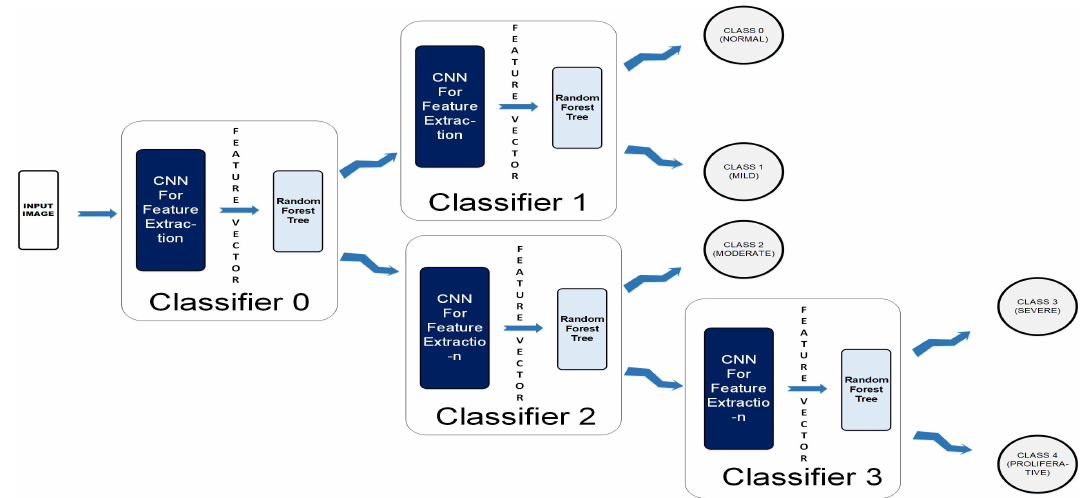
Figure 5. Framework 1-cascaded classifier